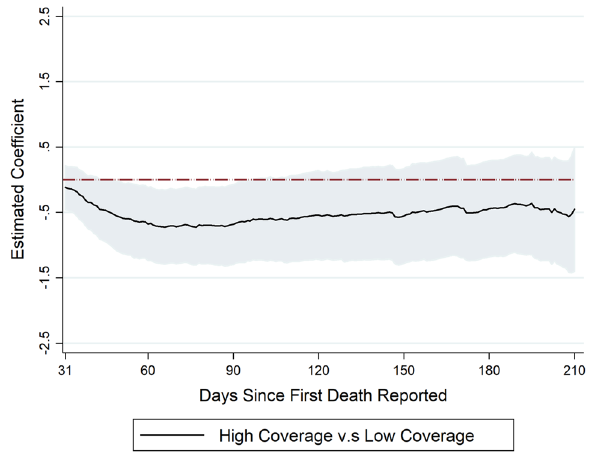
Figure 3. (Model 3) This figure summarizes the estimated effects of high BCG coverage (vs low BCG coverage) on cumulative deaths in logarithm since the first death reported. The coefficients are estimated effects of BCG vaccination program for day 31 to day 210, compared to the first 30 days. The effect of high BCG coverage estimates of α k are from Eq.